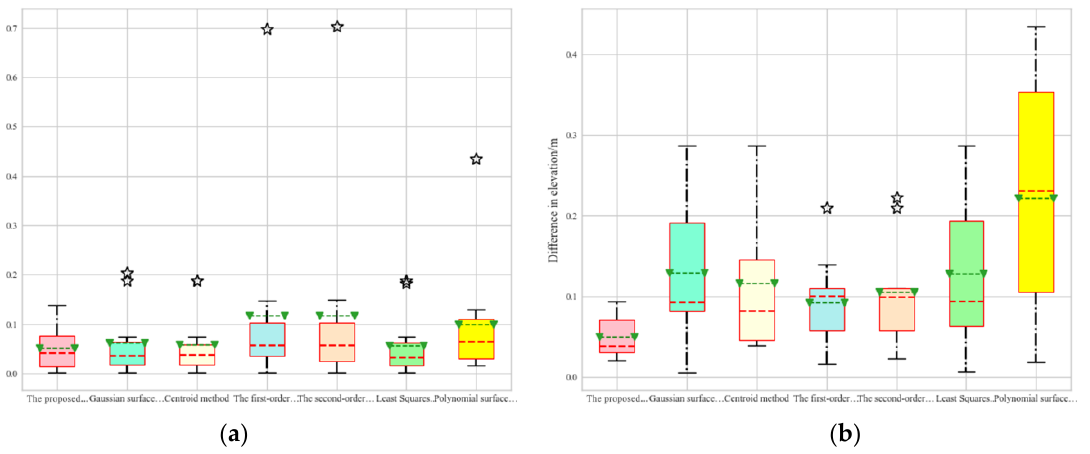
Figure 13. ( a ) Elevation accuracy verification results of laser footprints positioned using different methods for Beam 1 in 2021; ( b ) Elevation accuracy verification results of laser footprints positioned using different methods for Beam 2 (the green dotted line is the mean value of elevation difference, the red dotted line is the corresponding median, and the five-pointed star is the abnormal value).